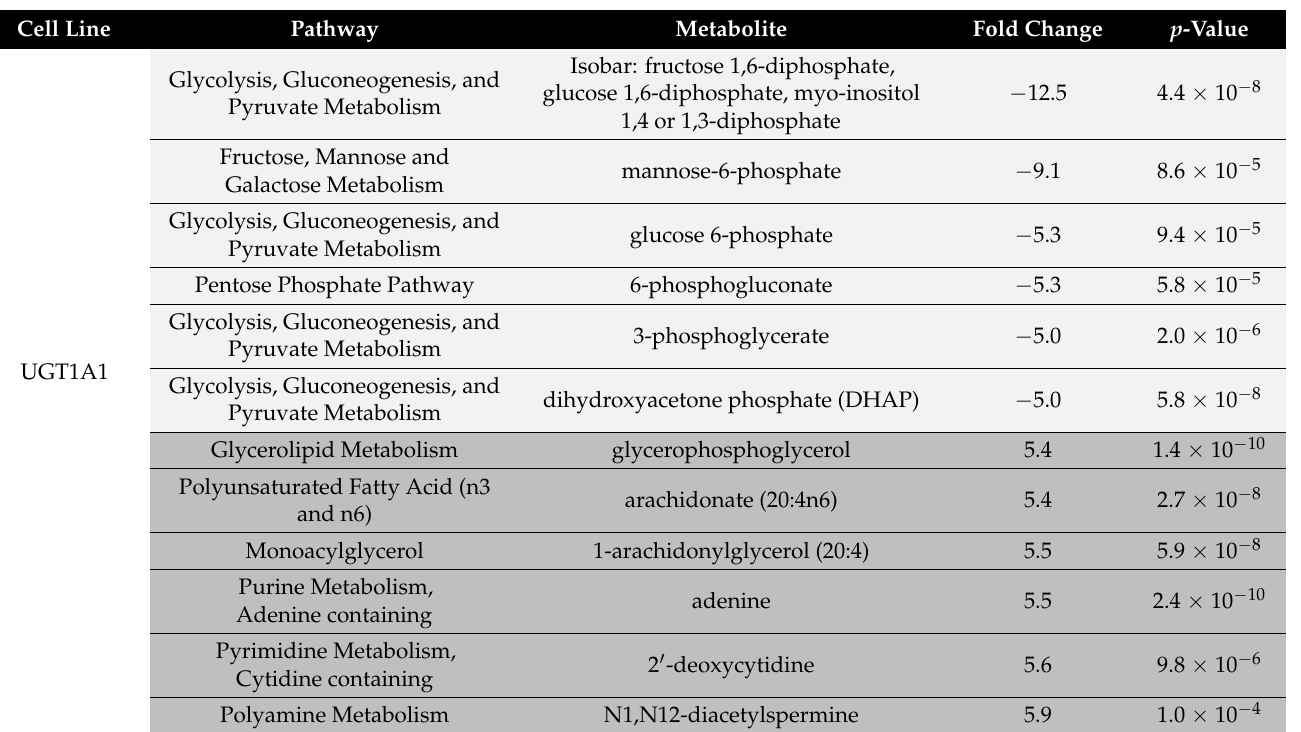
Table 2. Top modulated metabolites in UGT-expressing